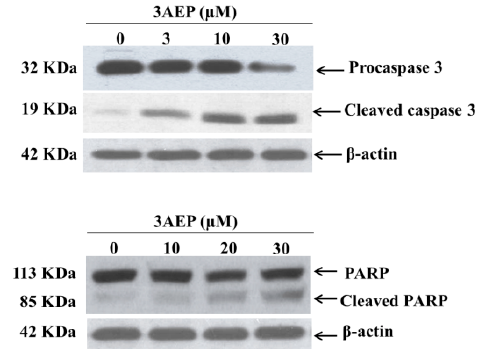
Figure 3. Caspase 3 and PARP degradation protein expression by 3AEP in HL-60. Cells were treated with 3AEP (0–30 µM) for 48 h. Protein 50 µg/lane from cells lysates were electrophoresed on SDS-PAGE gels, and then transferred to total blot PVDF membranes. β -actin was used as a control, (–), 0.1% DMSO-treated cells. The experiments were carried out in three experiments.